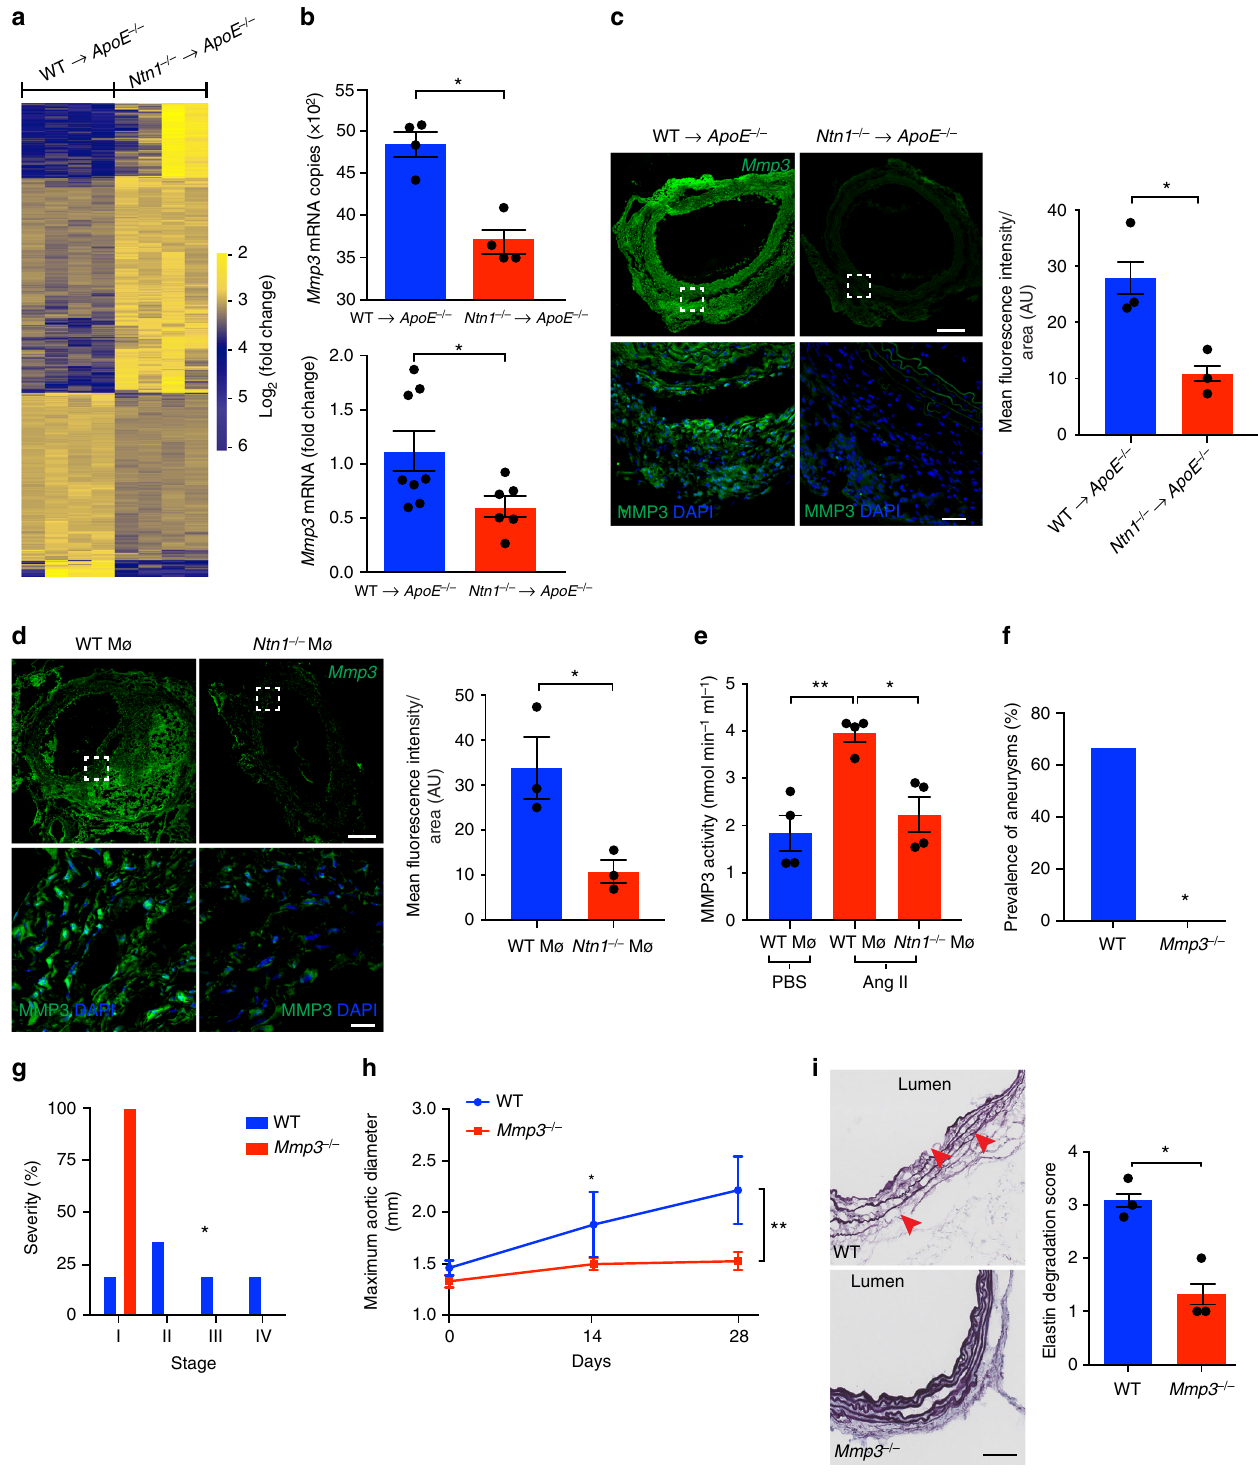
vascular cells within the arterial wall might contribute to the development of AAA. Stimulation of endothelial cells or fi bro- blasts with increasing concentrations of recombinant netrin-1 did not increase the activity of MMP3 (supplementary Figure 3e, f). However, exposure of murine primary VSMCs to recombinant netrin-1 signi fi cantly induced the enzymatic activity of MMP3 in a dose-dependent way (Fig. 5e). Notably, the co-culture of acti- vated WT macrophages with VSMCs in transwell